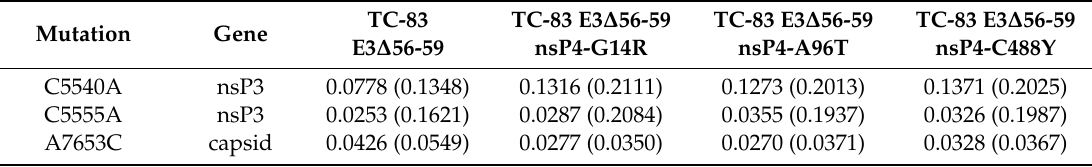
Table 1. Average frequency of common mutations seen samples. Mutation frequency Analysis A (Analysis